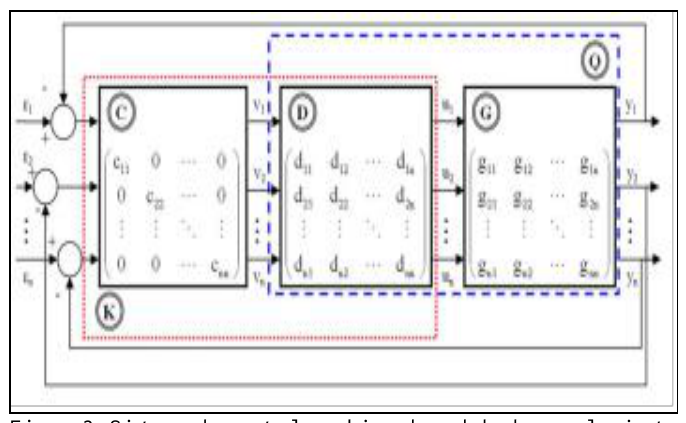
Figura 3: Sistema de control combinando red de desacoplamiento y controlador descentralizado.